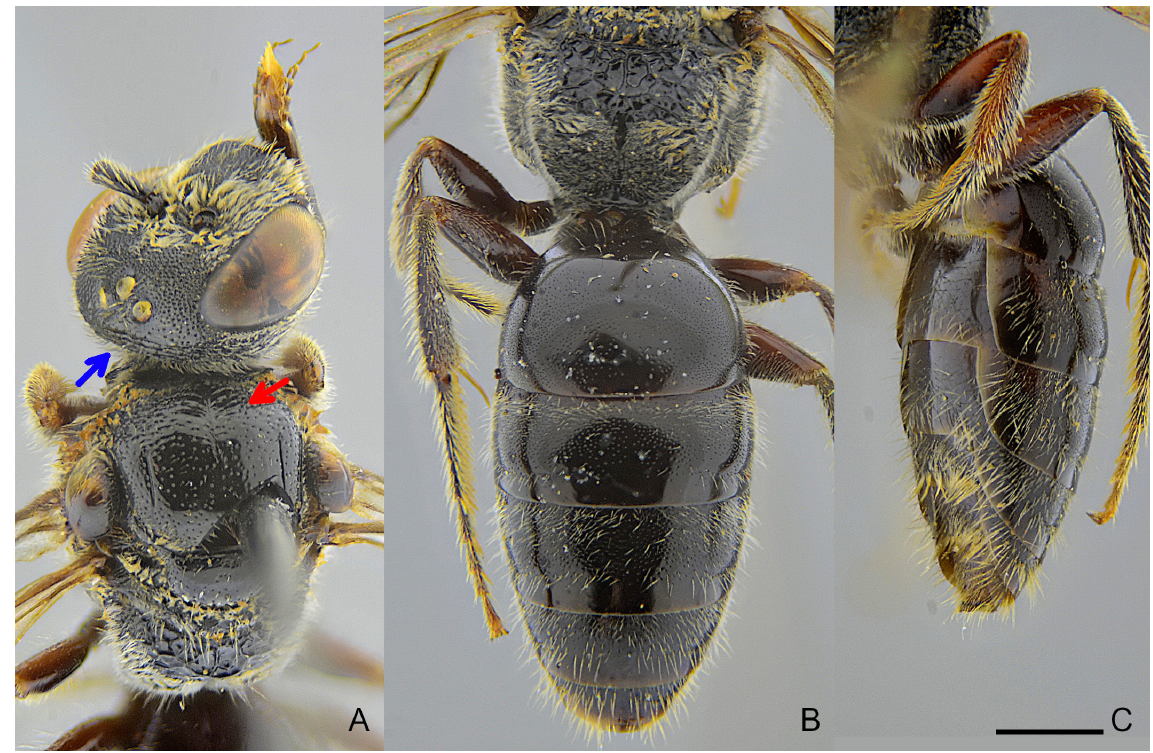
Fig. 5. Austrosphecodes jurupari sp. nov., holotype ♂ (RPSP). A . Head and mesosoma, blue arrow: strigate vertex, red arrow: carinate anterior margin of mesoscutum. B . Propodeum and metasoma. C . Metasomal sterna. Scale bar = 1